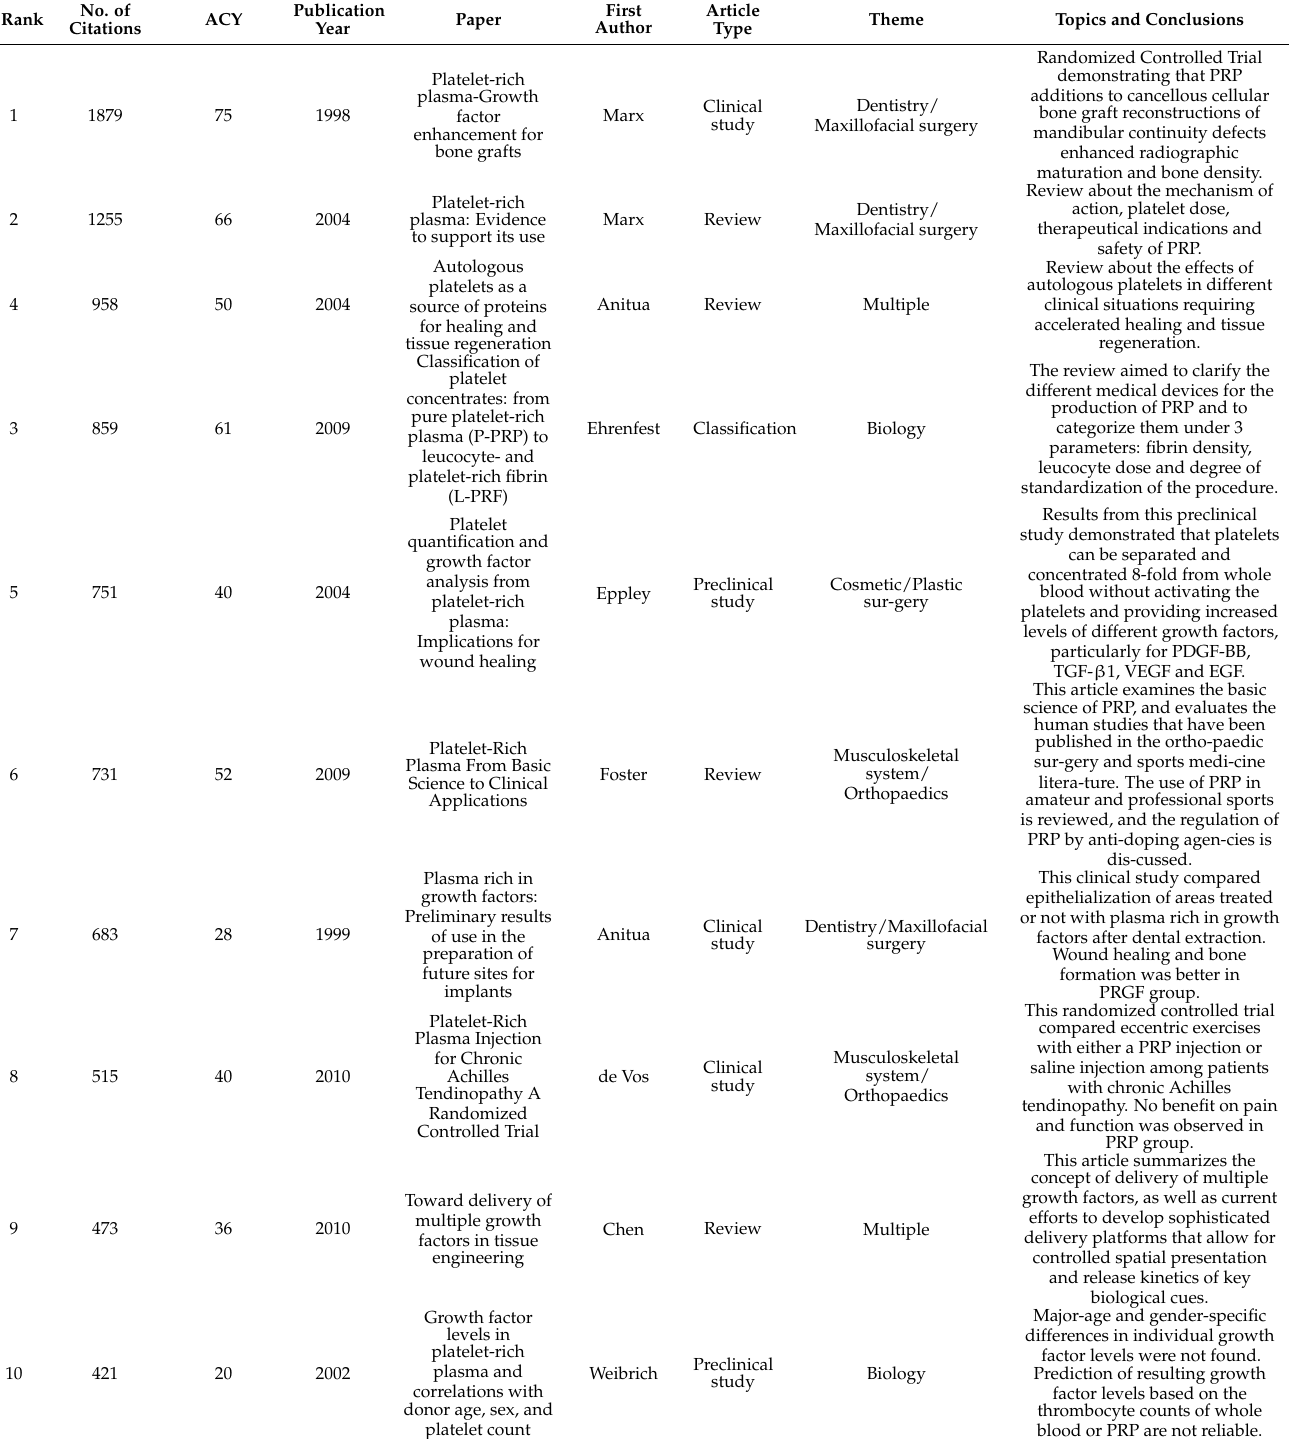
Table A2. Topics and conclusions of the overall top 10 cited